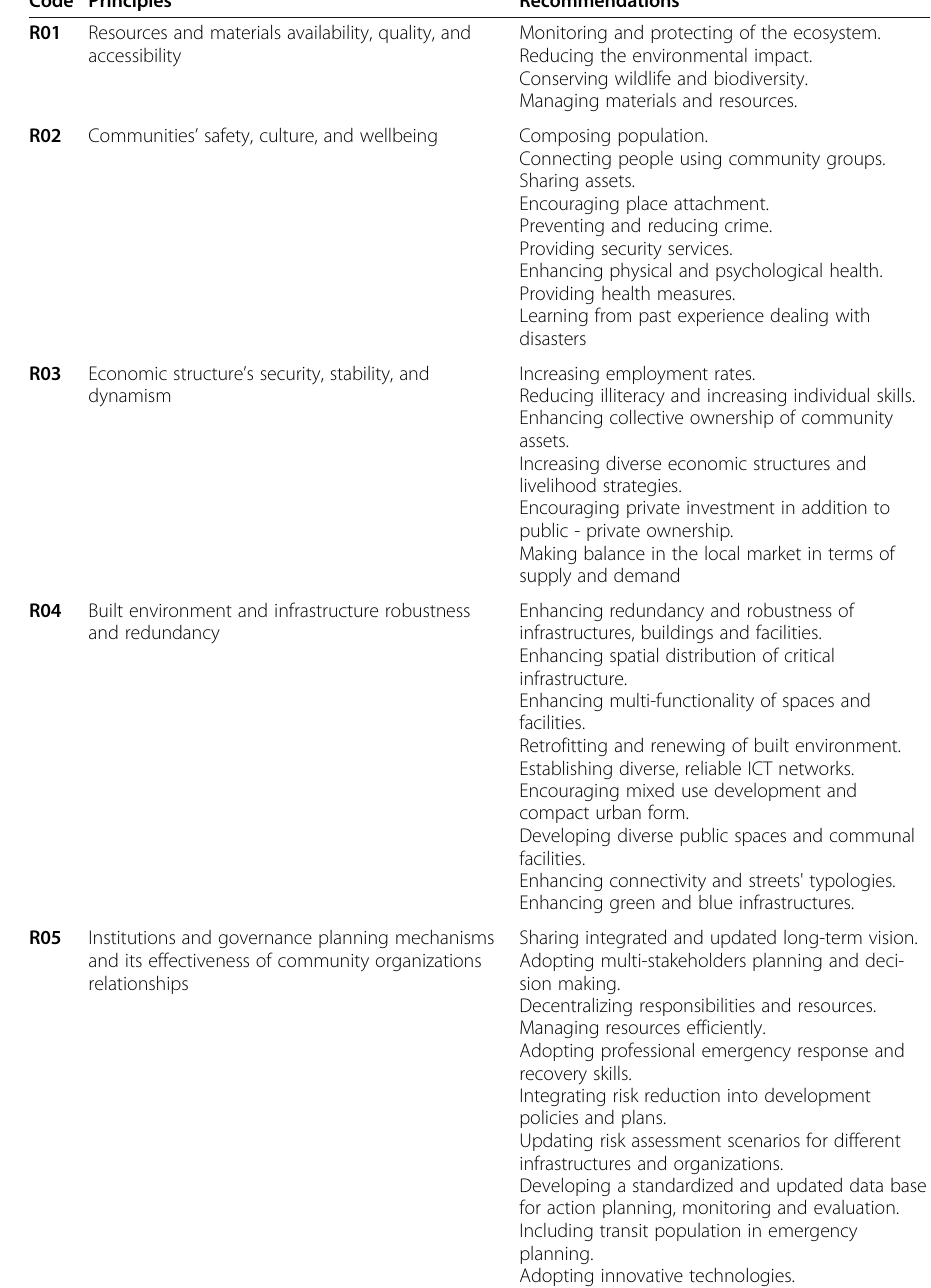
Table 1 Principles of urban resilience adopted from [19, 20, 23] Code